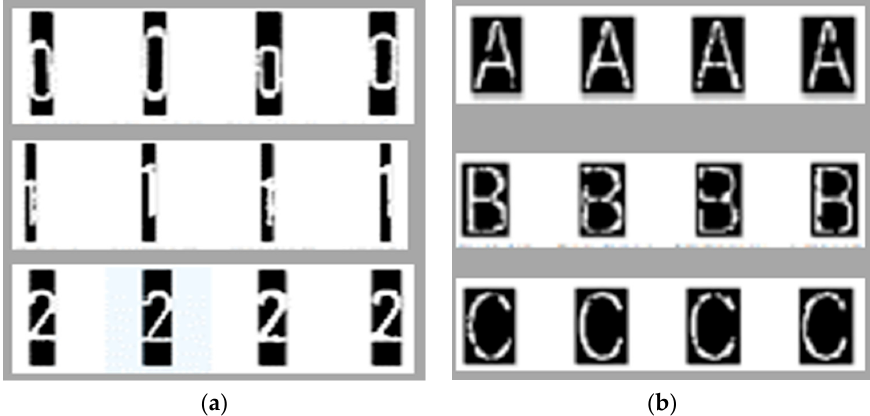
Figure 12. ( a ) Numerical and ( b ) alphabetical characters in the printed dataset.